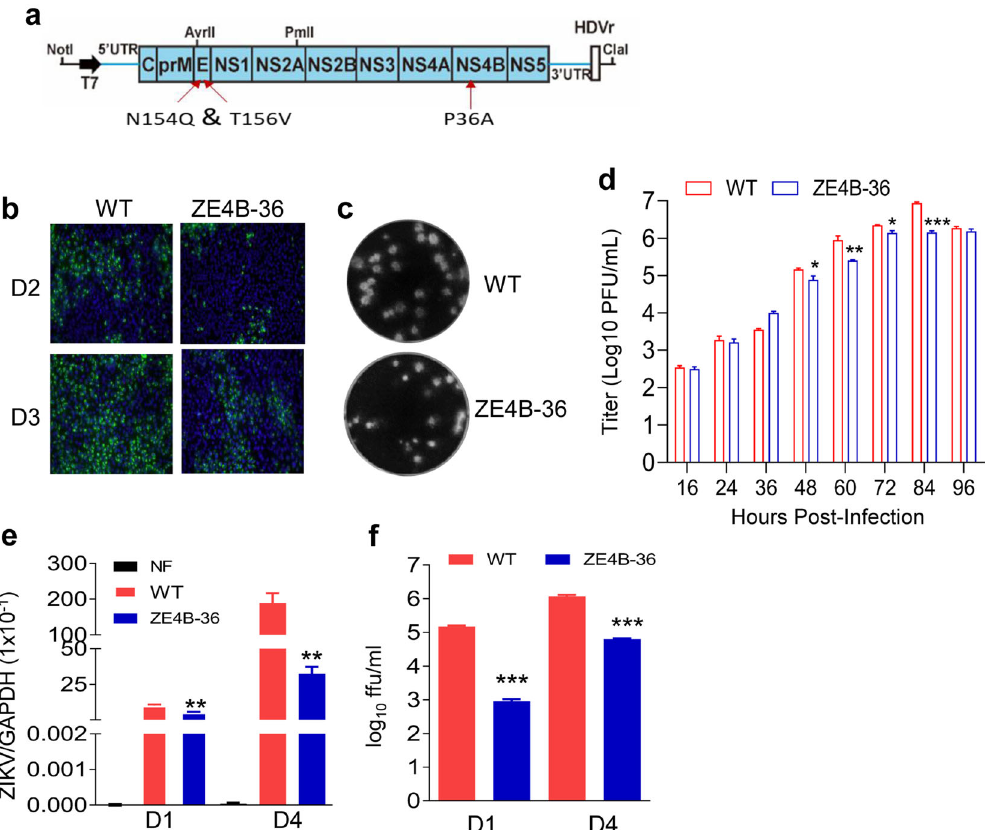
Fig. 1 Characterization of ZE4B-36 replication in cell culture. a Schematic of construction of ZIKV FSS13025 mutant virus. Restriction enzyme sites used for cloning are indicated. b IFA of viral protein expression in Vero cells transfected with WT FSS13025ic (WT) and ZE4B-36 RNAs. Vero cells were electroporated with 10 μ g genome-length WT and ZE4B-36 RNAs RNA. On days 2 and 3 post transfection, IFA was performed to examine viral E protein expression using a mouse mAb (4G2). c Plaque morphologies of WT and ZE4B-36 viruses. Plaques were developed on a Vero cell monolayer after 4 days of infection. d Comparison of growth kinetics of WT FSS13025ic and ZE4B-36 viruses in Vero cells. Cells were infected with both viruses at an MOI of 0.01. Viral titers were measured at the indicated time points using plaque assays on Vero cells, n = 3. Means and SDs from three independent replicates are shown. e , f A549 cells were infected with WT FSS13025ic or ZE4B-36 virus at an MOI of 0.1. At days 1 and 4 pi, viral load was measured by Q-PCR ( e ) and FFA ( f ). n = 4 to 8. Data are presented as means ± standard error of the mean (s.e.m). *** P < 0.001 or ** P < 0.01 compared to WT